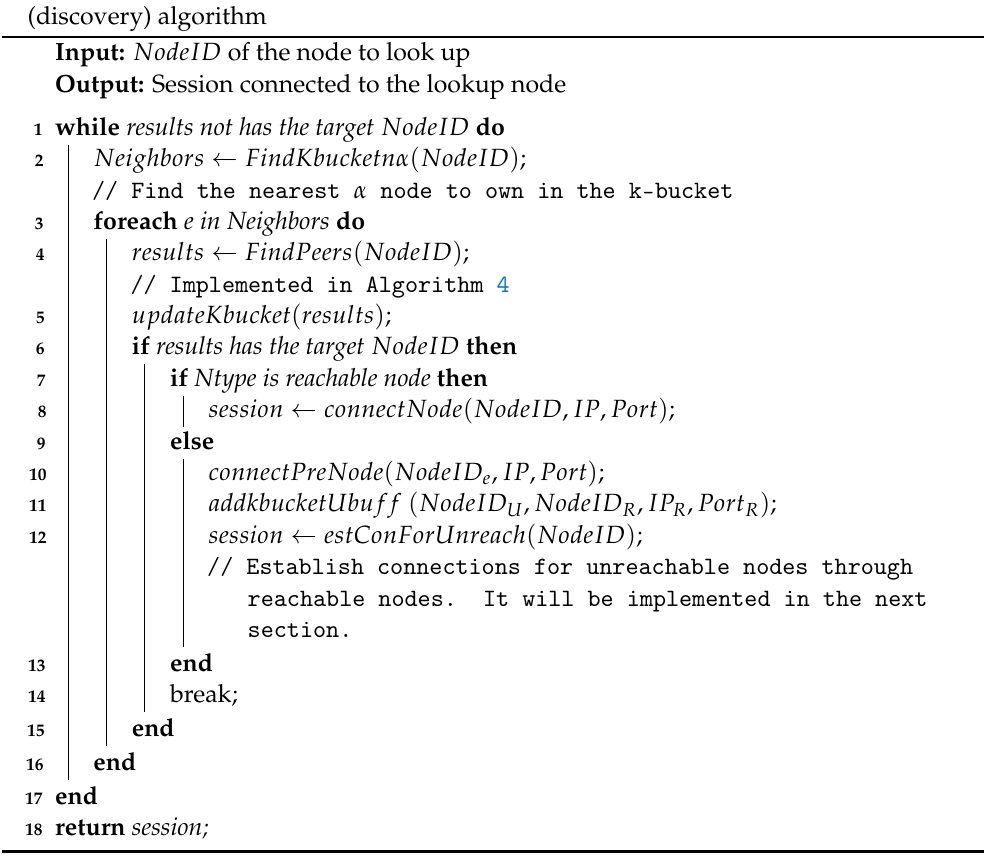
Algorithm 4: FindPeers() procedure in reachable